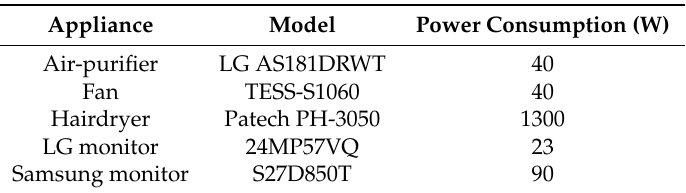
Table 1. Specifications of five appliances.